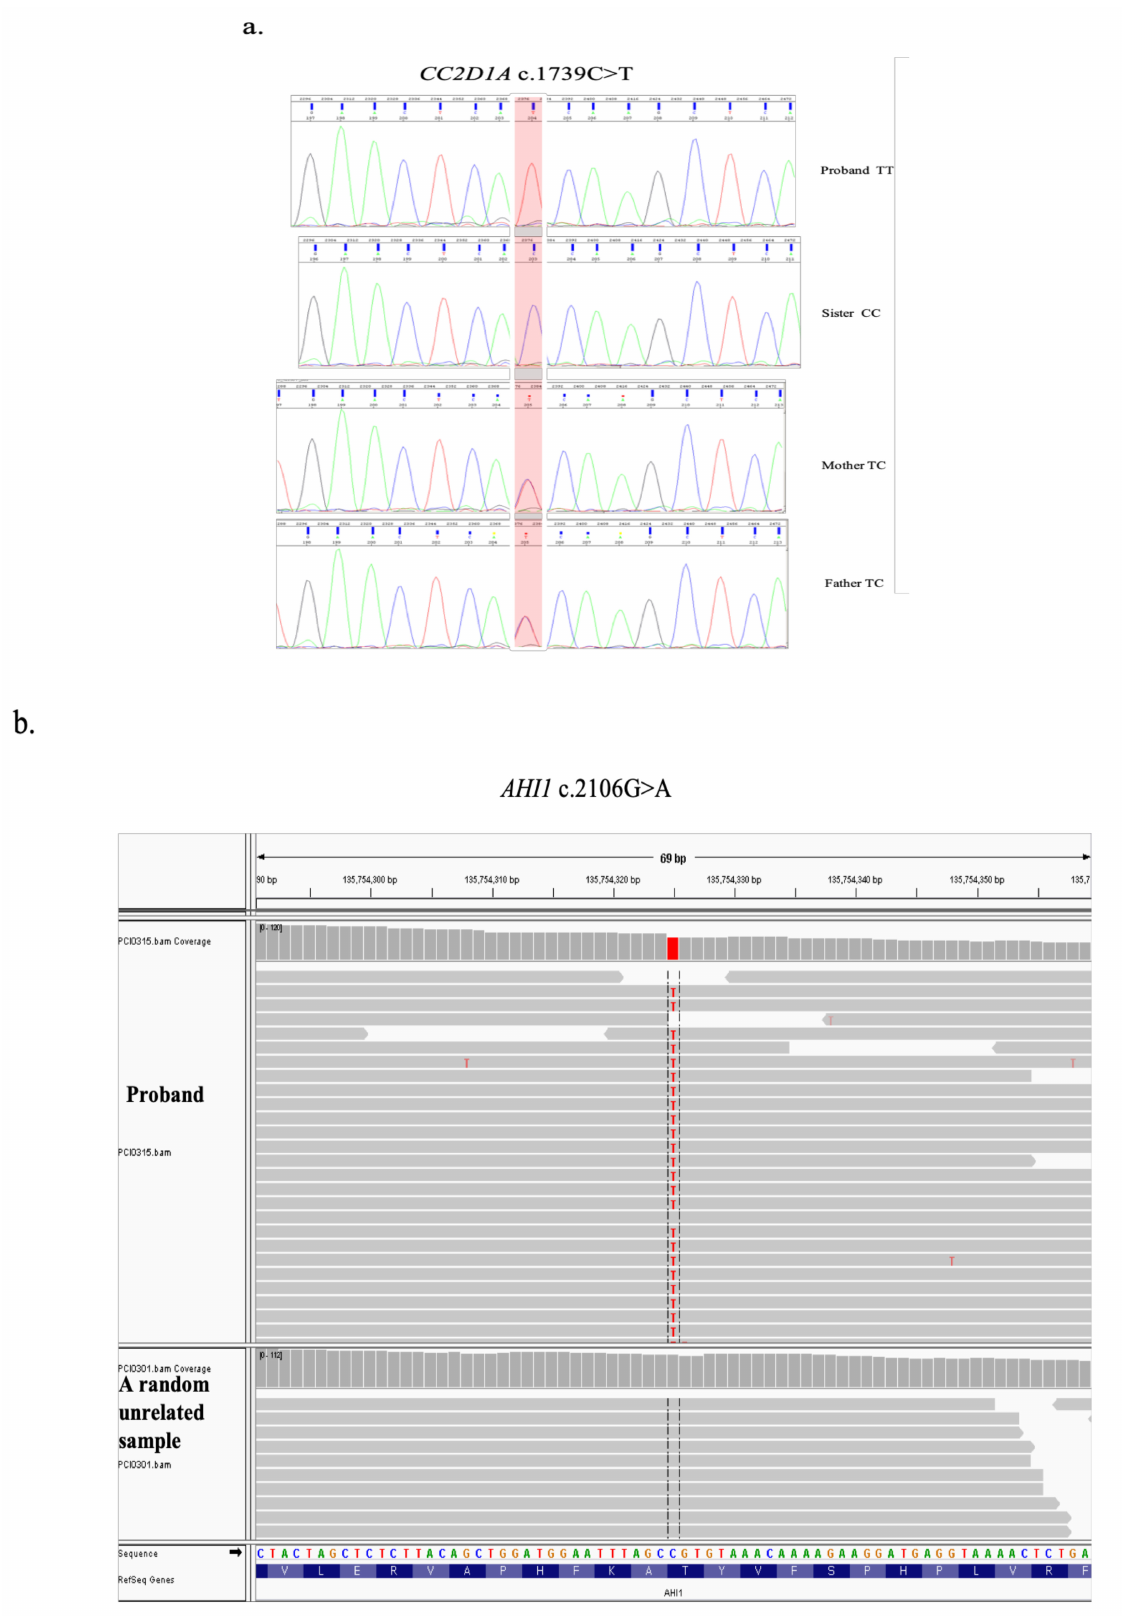
Figure 2. ( a ) Sanger sequencing results of the CC2D1A c.1739C>T variation in the proband (homozygous T), sister (homozygous C), and parents (heterozygous). ( b ) Whole genome sequencing results of the AHI1 c.2106G>A variant of the proband compared with random unrelated